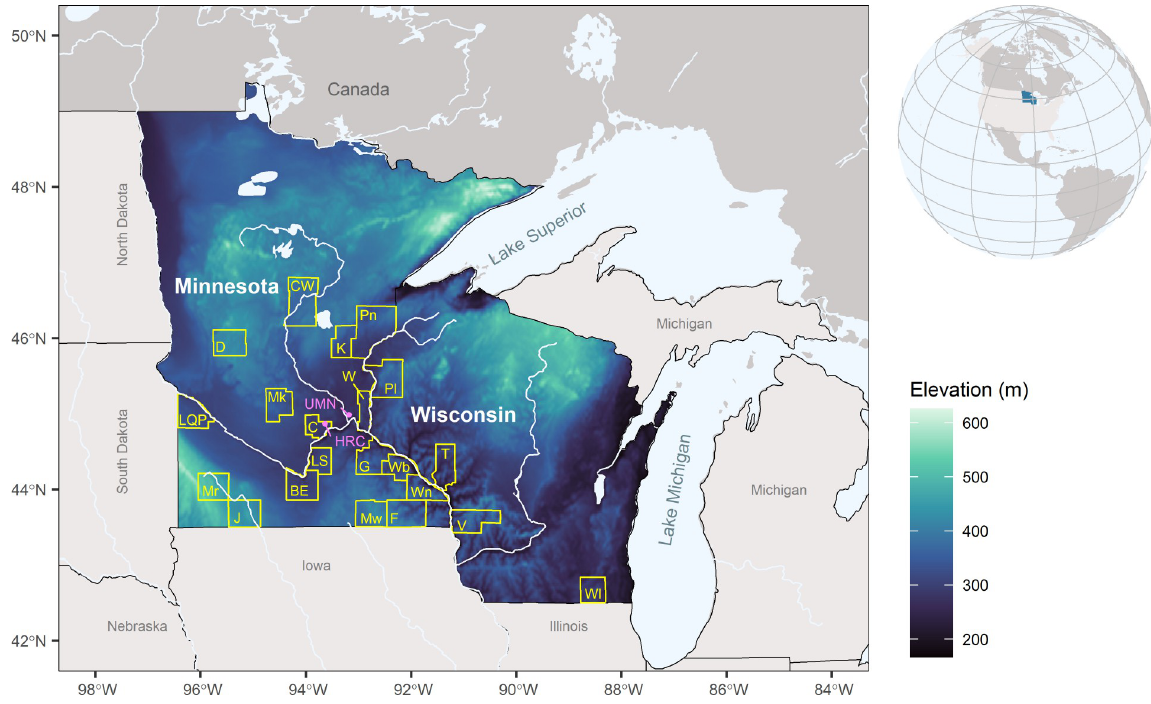
Fig 2. Map of counties sampled. Grapevine wood samples collected from Minnesota and Wisconsin counties traced in yellow included Blue Earth (BE), Carver (C), Crow Wing (CW), Douglas (D), Fillmore (F), Goodhue (G), Jackson (J), Kanabec (K), Lac Qui Parle (LQP), Le Sueur (LS), Meeker (Mk), Mower (Mw), Murray (Mr), Pine (Pn), Polk (Pl), Trempealeau (T), Vernon (V), Wabasha (Wb), Walworth (Wl), Washington (W), and Winona (Wn). Color scale indicates elevation in meters. Pink points denote locations of the University of Minnesota (UMN) St. Paul campus and the UMN Horticultural Research Center (HRC) where the grape breeding program is located and where several samples were collected. Map constructed in R with the public domain map collections Natural Earth (https://www.naturalearthdata.com/) and Terrain Tiles (https://registry.opendata.aws/terrain-tiles/).